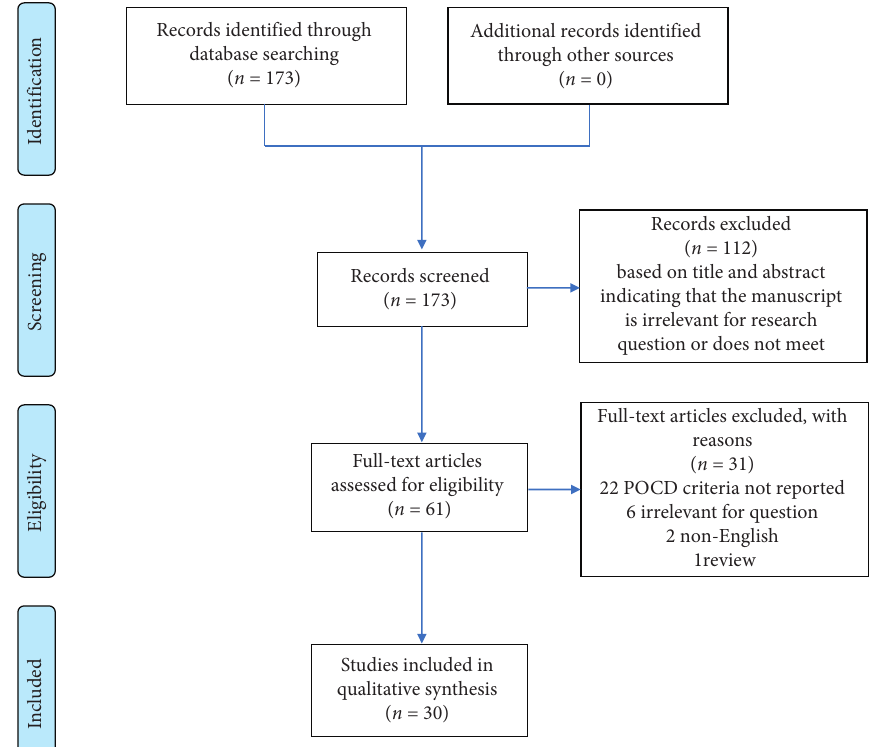
Figure 1: Flow diagram of studies included in the systematic